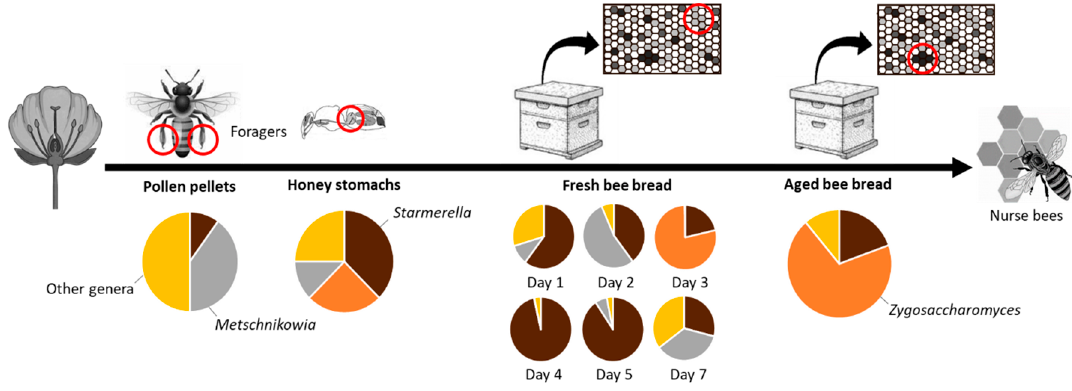
Figure 3. Distribution of main yeast genera associated with the gathering and storage of pollen by honey bees from pollen pellets and honey stomachs to fresh and aged been bread stored in the hives.